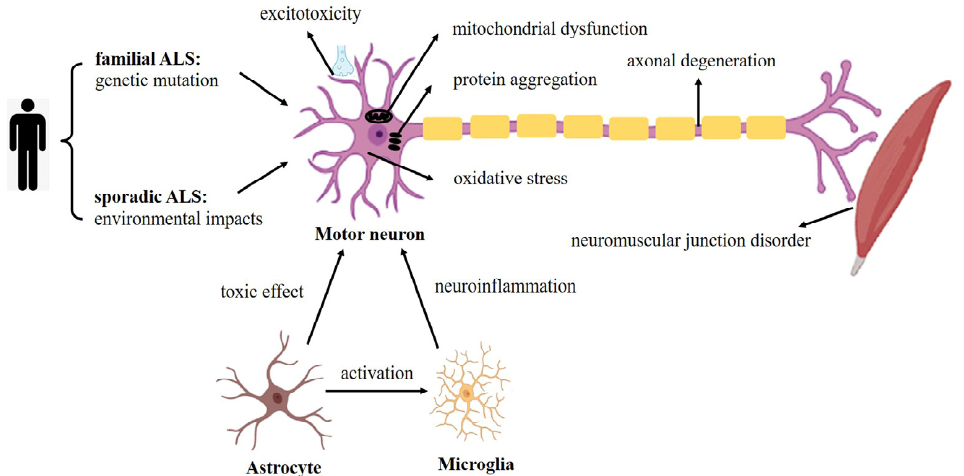
Figure 2. Summary of pathogenesis using iPSC-derived motor neurons and glial cells taken from fALS and sALS patients, which is largely consistent with the pathogenesis of ALS seen in animal models and postmortem tissue.